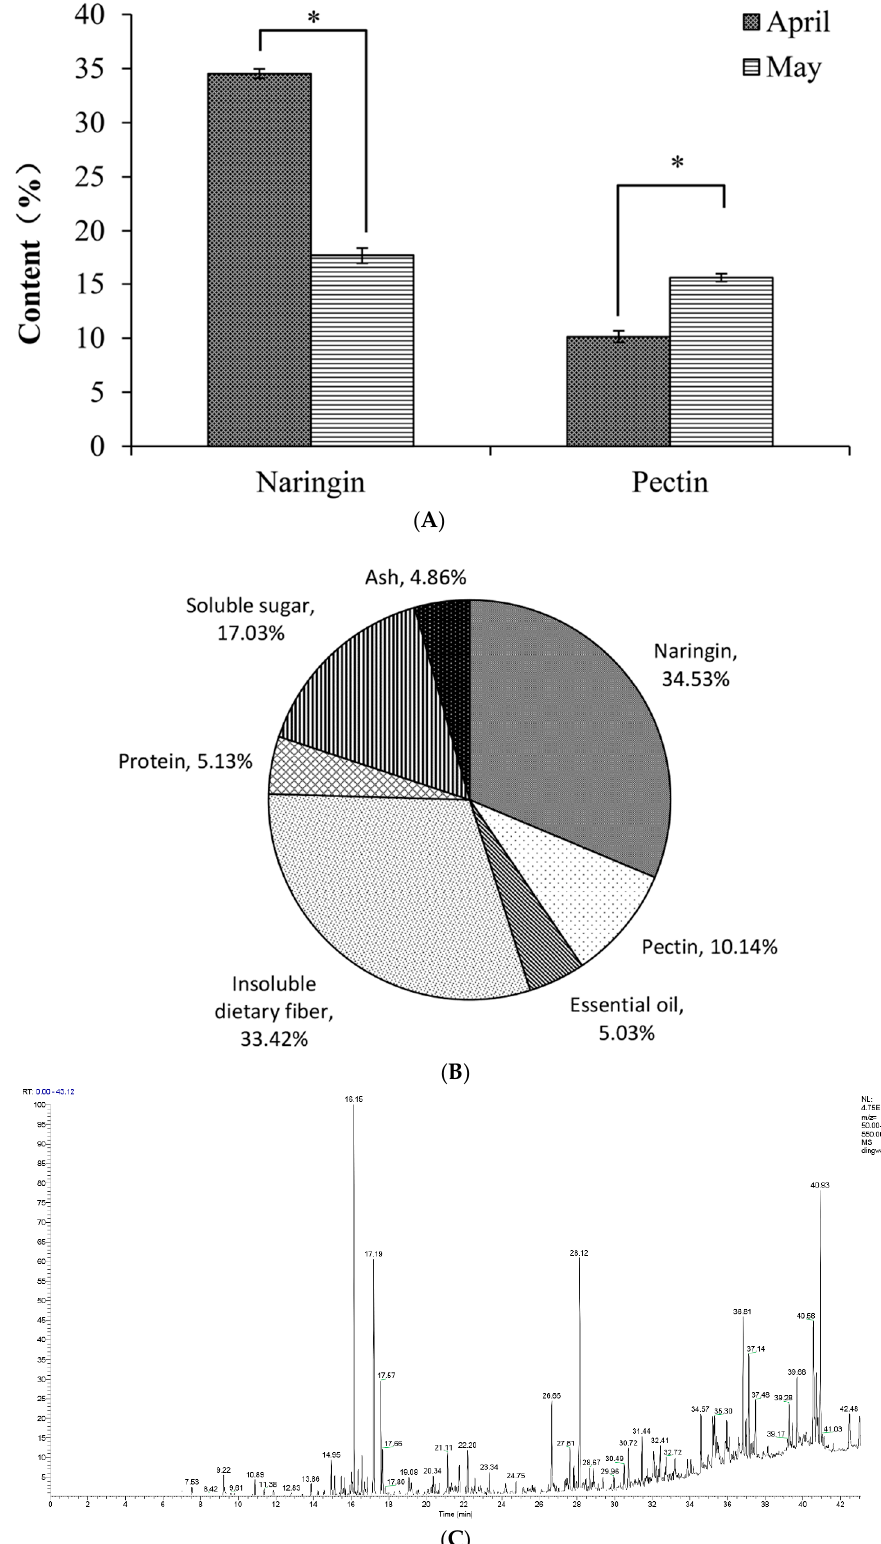
Figure 2. ( A ) Naringin and pectin content in immature honey pomelo fruit in April and May, respectively; ( B ) The composition of immature honey pomelo fruit in April; ( C ) Chromatogram (GC-MS) of IPF essential oil. Results were presented as the mean ± SD ( n = 3). The asterisks in the bar chart indicate statistical significance between groups according to Student’s t -test ( p < 0.05).